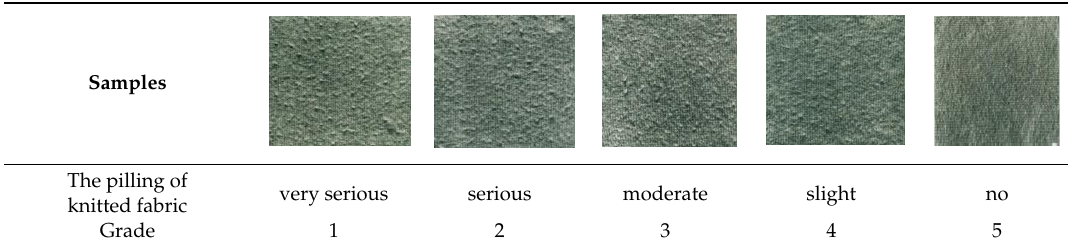
Figure 1. Flowchart of pilling grade classification of knitted fabric.